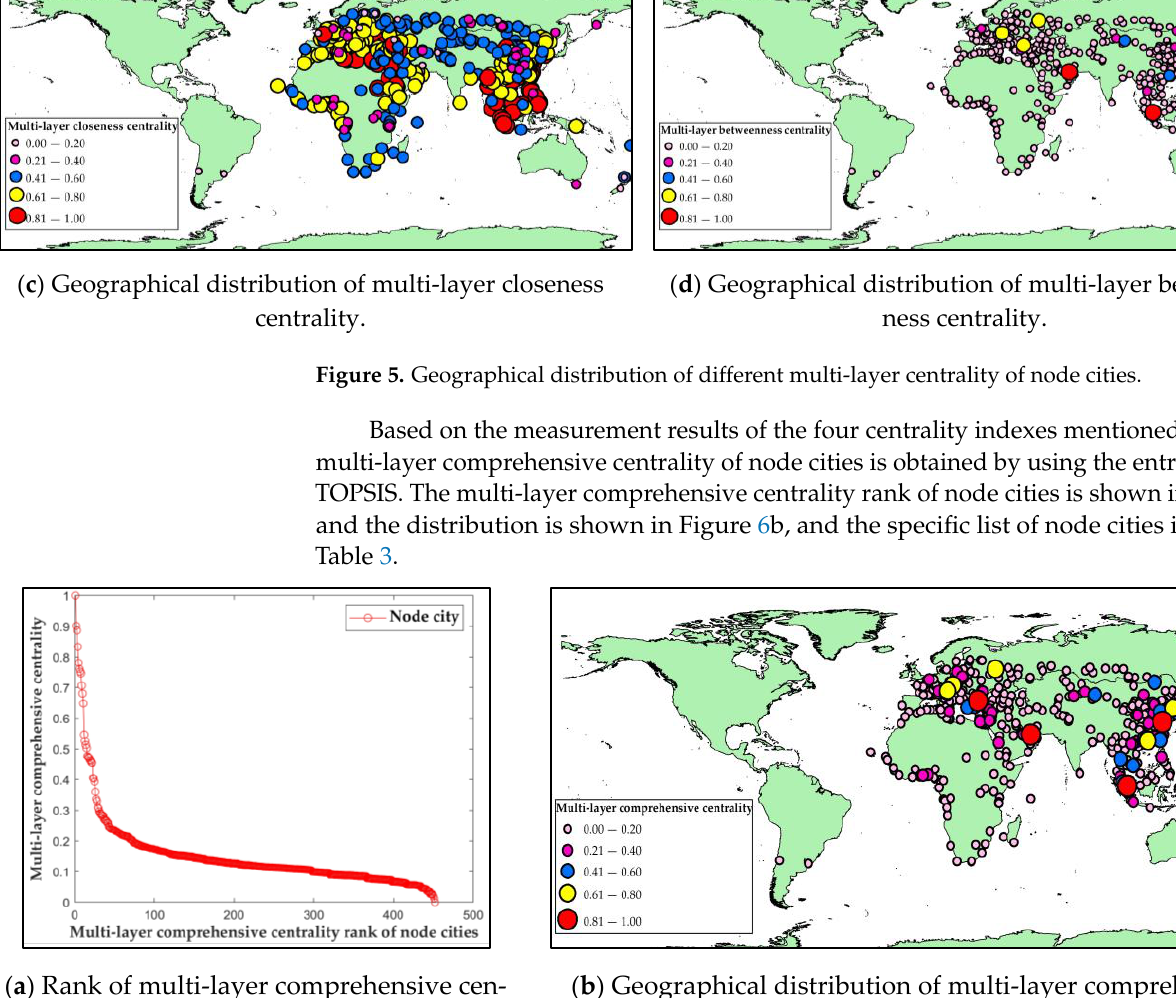
Figure 6. Multi-layer comprehensive centrality rank of node cities and its distribution. Table 3. Node cities in different regions of multi-layer comprehensive centrality.